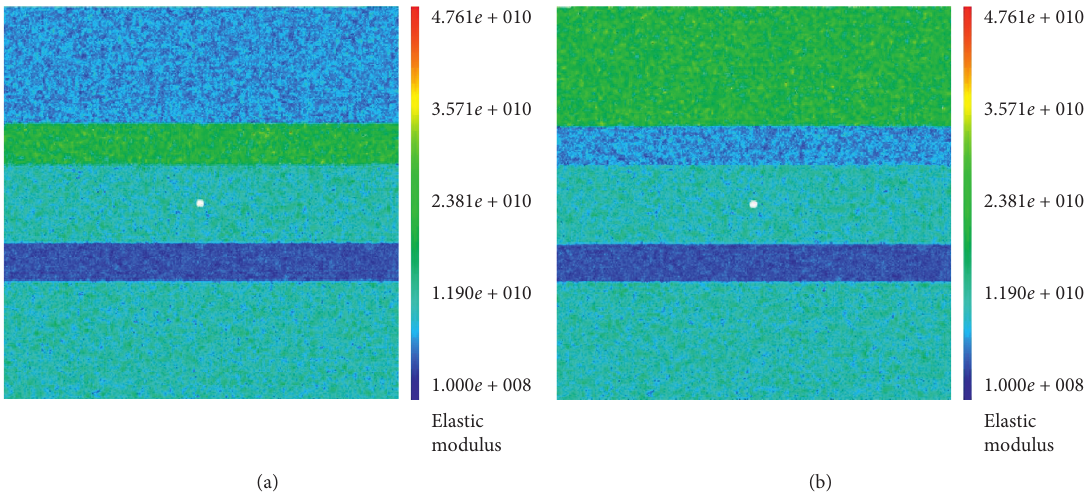
Figure 3: Elasticity modulus of different numerical models. (a) Model No. 1. (b) Model No.